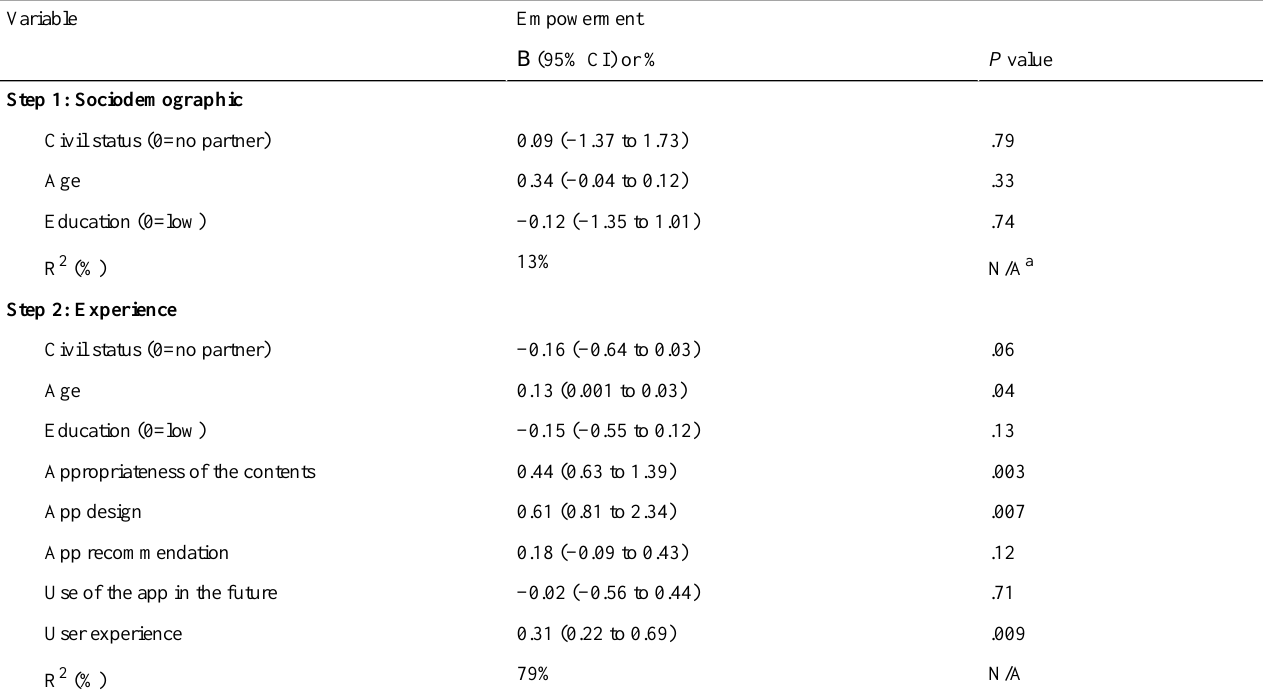
Table 4. Regression